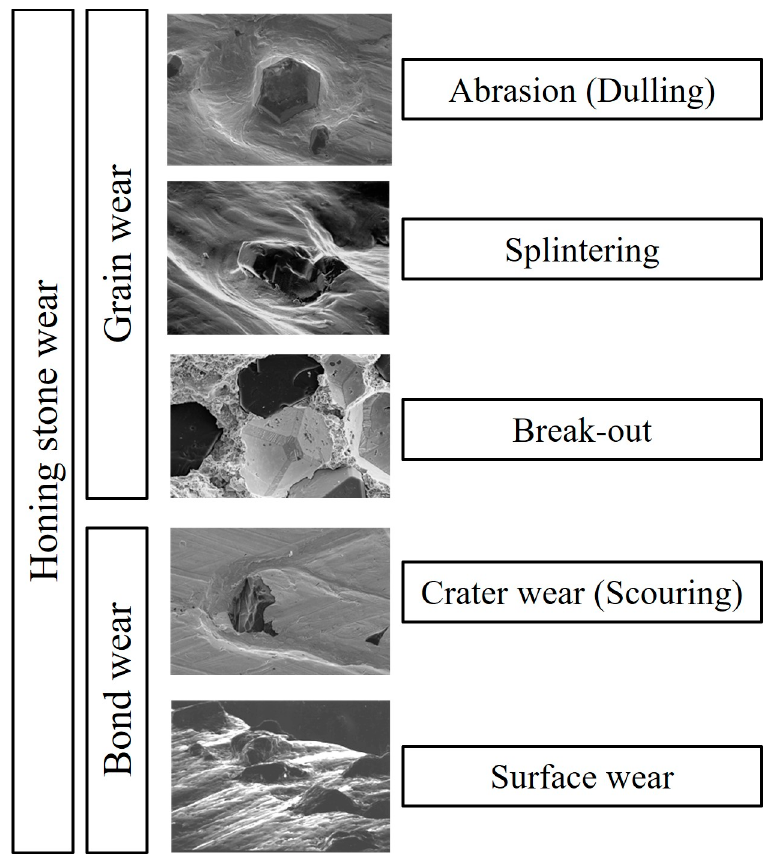
Figure 1. Types of honing stone wear, according to [3].